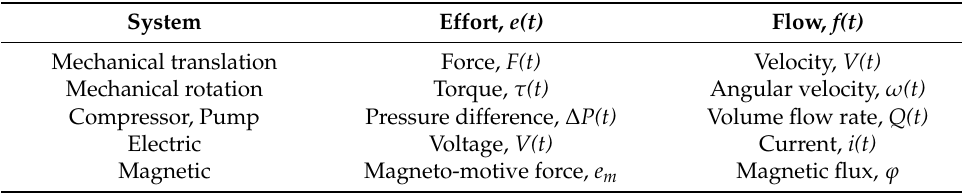
Table 2. Power definition in a multi-port